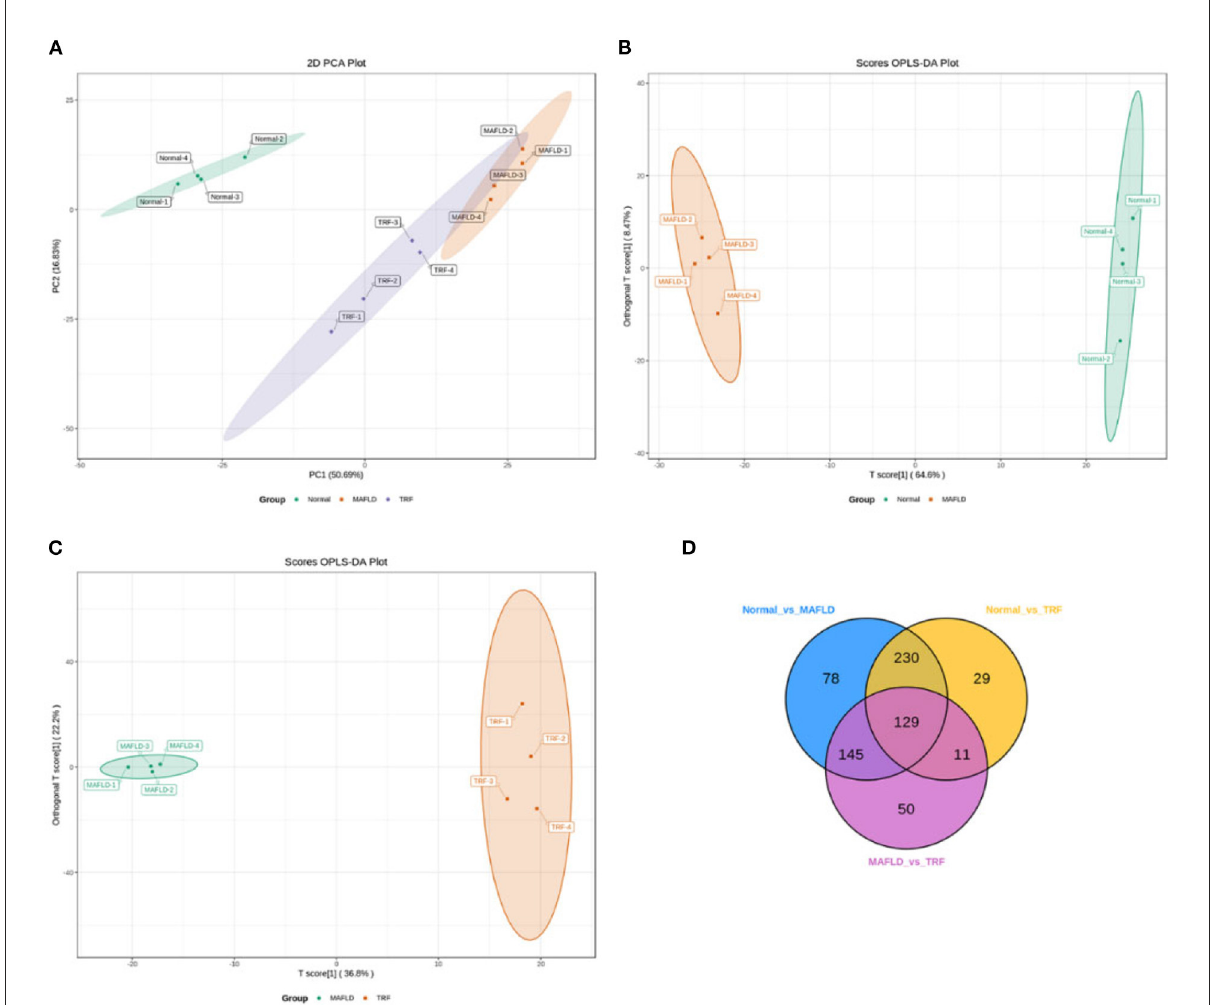
FIGURE6 Liver lipidomics results. PCA for all groups (A) . OPLS-DA scores plots (B,C) of Normal vs. MAFLD and MAFLD vs. TRF, respectively. In the Venn diagram (D) , each circle represents a comparison group, the number of circles and overlapped parts represent the number of common differential metabolites between the comparison groups, and the number of non-overlapped parts represents the number of unique differential metabolites in the comparison groups. Normal, rats fed a normal diet ad libitum ; MAFLD (metabolic associated fatty liver disease), rats fed a high-fat diet ad libitum ; TRF (time-restricted feeding), rats fed high-fat diet (60 kcal% fat) strictly between 16:00 and 22:00 every